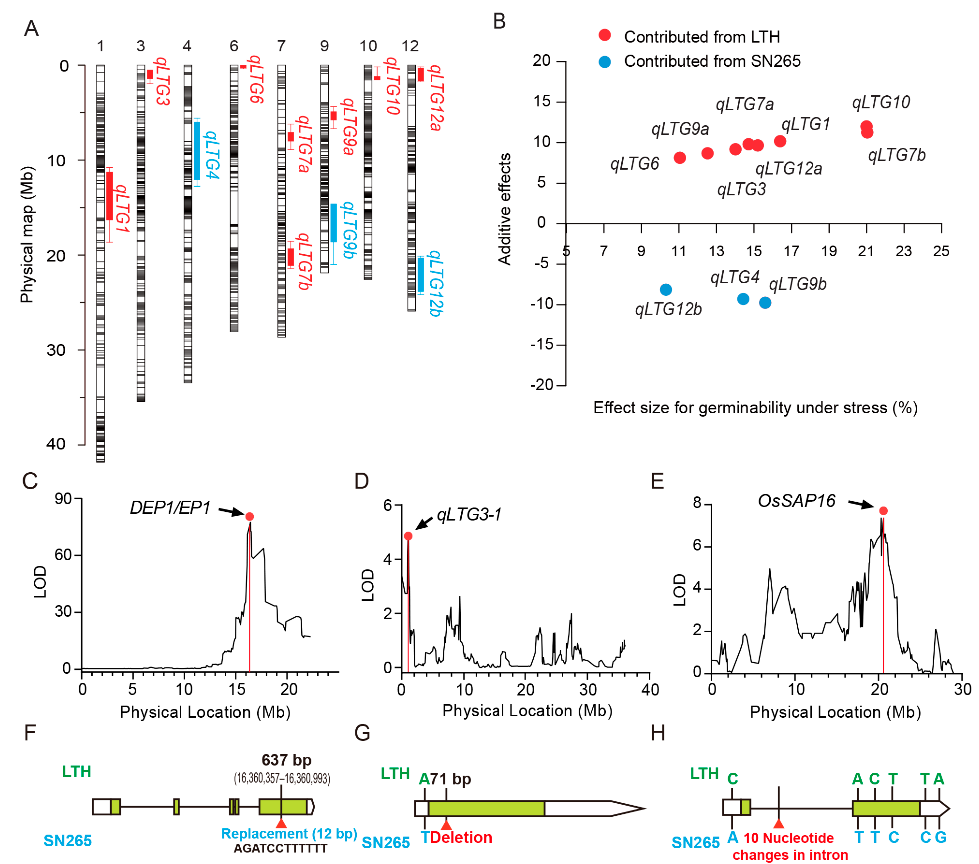
Figure 3. ( A ). QTL scan using whole-genome sequencing and a sequence comparing the panicle curvature and low-temperature germinability QTLs near the previously identified genes. Curves indicate the chromosome locations (Mb) and the low-temperature germinability (LOD) values of the detectedQTLs. Arrowheadsrepresenttherelativegeneticpositionsofthecandidategenes. ( A ).Genomic locations of the 11 QTLs with strong e ff ects for low-temperature germinability (LOD > 3) identified in the RIL population; ( B ). Plots of the additive e ff ect and the allele e ff ect of the 11 QTLs. ( C ). A plot of the LOD values of the panicle curvature. ( D ). A plot of the LOD values of the low-temperature germinability on chromosome 3. ( E ). A plot of the LOD values of low-temperature germinability on chromosome 7. ( F ). Sequence comparisons of the DEP1 region between LTH and SN265. ( G ). Sequence comparisons of the qLTG3-1 region between LTH and SN265. ( H ). Sequence comparisons of the OsSAP16 region between LTH and